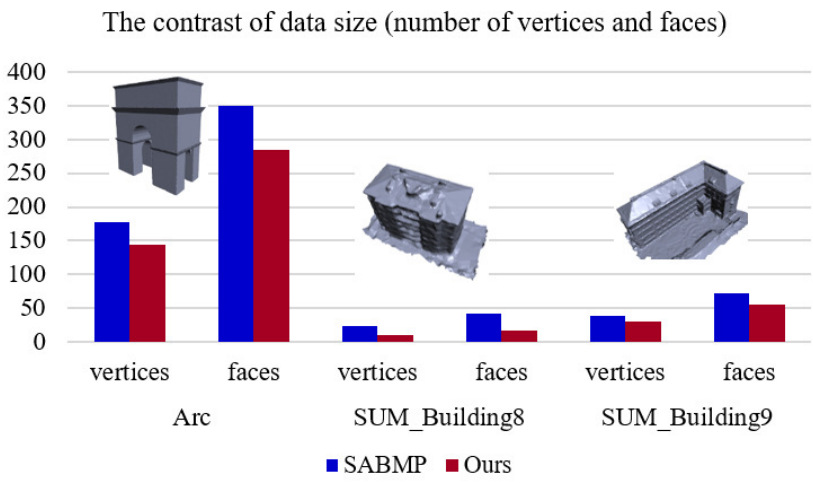
Figure 16. Comparison of models with corner point clumps in terms of output data size.